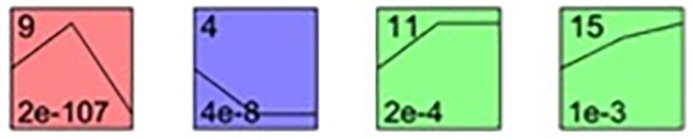
The four significant gene profiles identified using the STEM application. Three ‘time points’ are visible on the plots, representing changes in expression of the respective gene clusters from controls (point 1) to DH (point 2), and DH treated with TO (point 3). Profile number (see Table 2) is displayed in the top left, P-value bottom left. The colors are to illustrate that the changes in expression are similar in profiles 11 and 15 but different from 9 and 4.